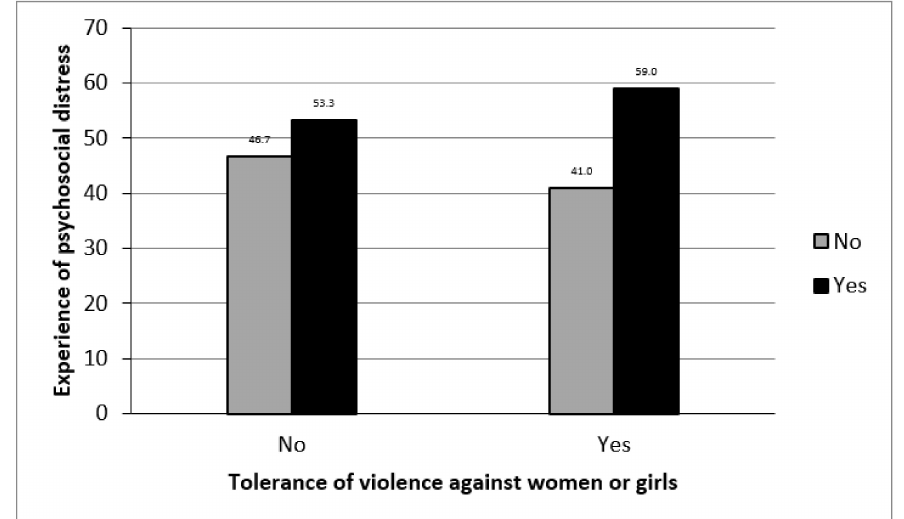
Figure 1. Tolerance of violence against women and experience of psychosocial distress.